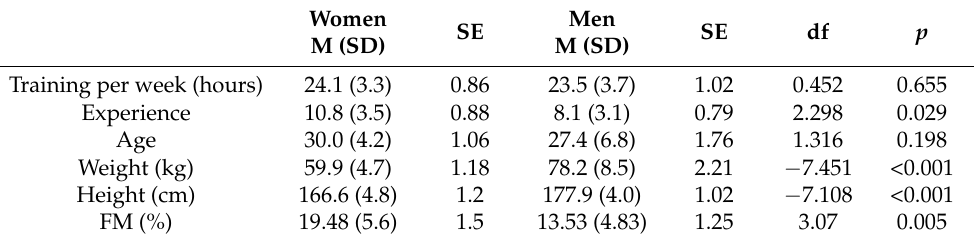
Table 1. Characteristics of the professional women and men padel